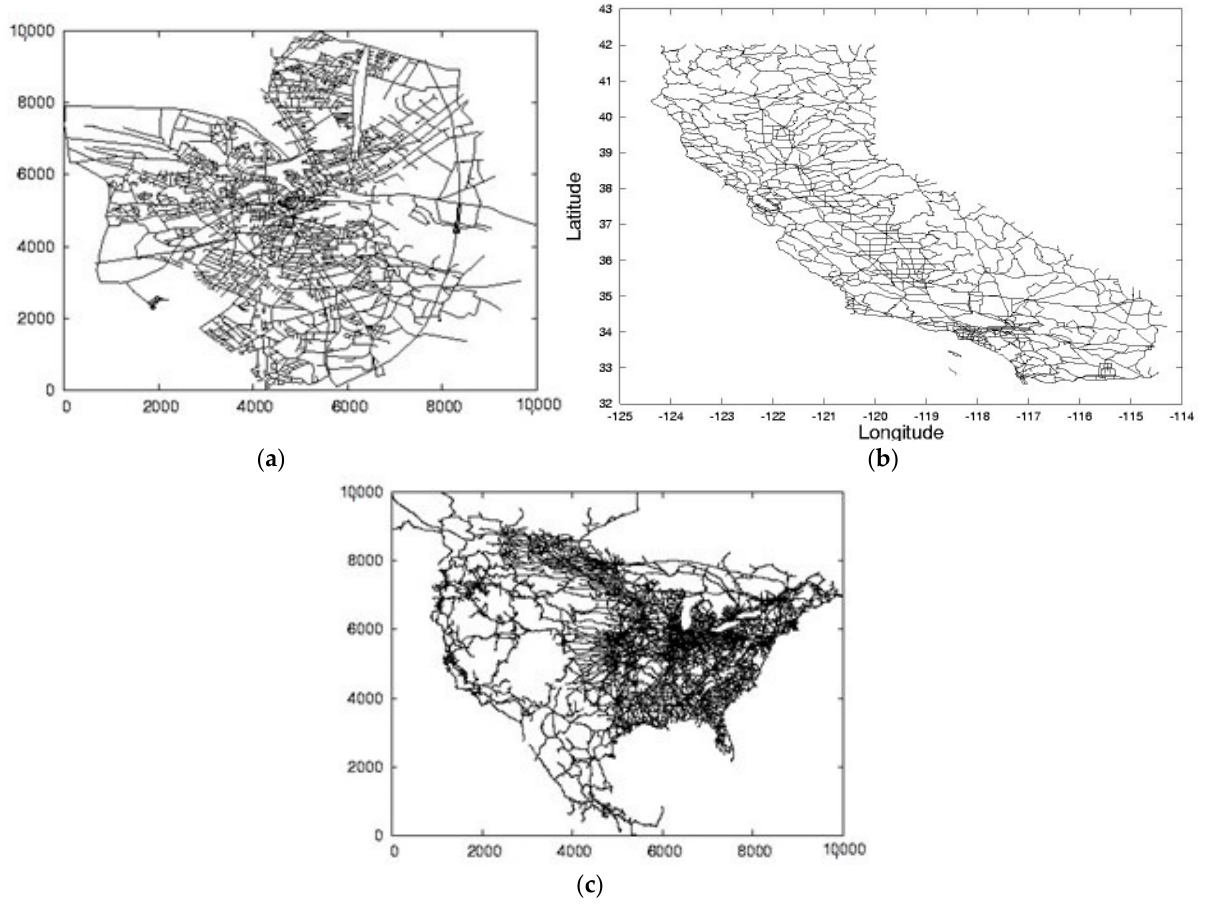
Figure 11. Roadmap datasets: ( a ) Oldenburg, ( b ) California, ( c ) North America. Table 3. Summary of experiment